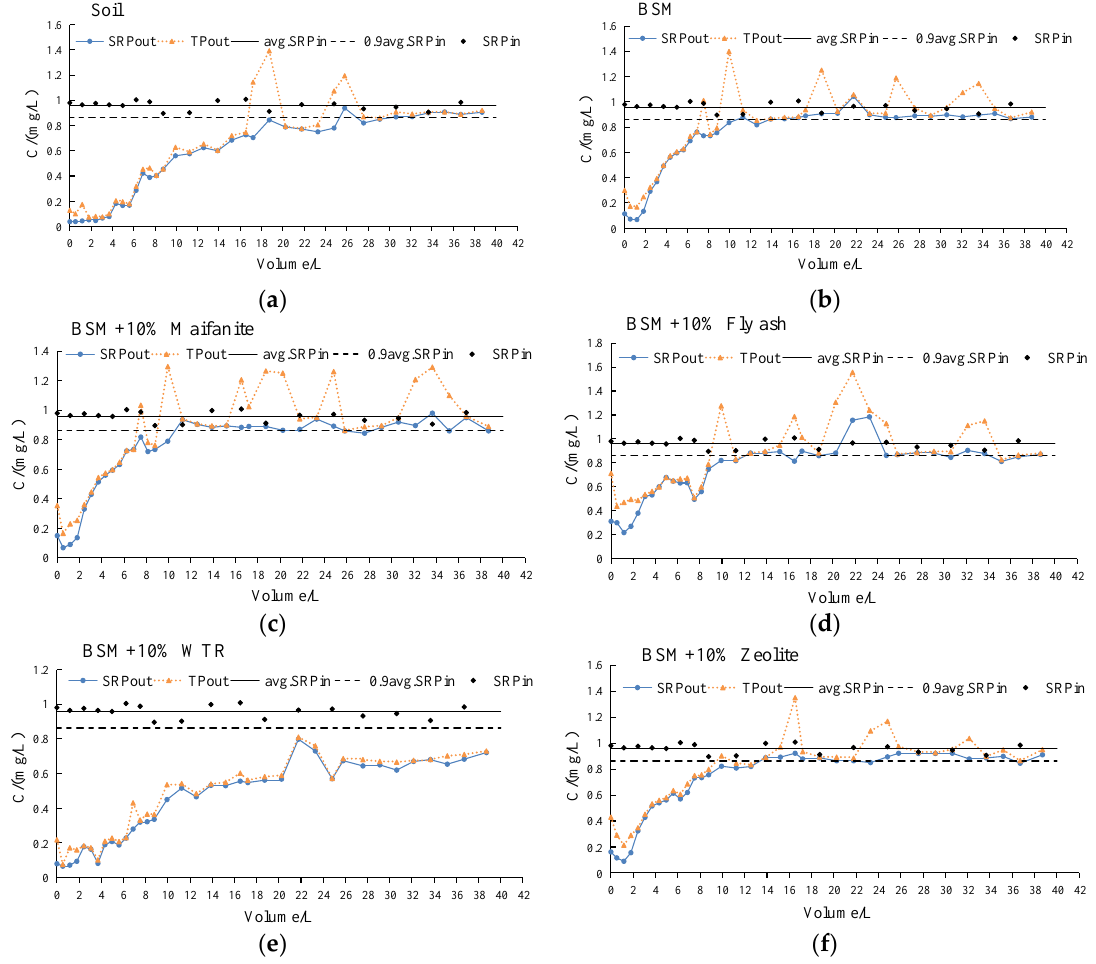
Figure 4. Dynamic adsorption curves of ( a ) soil, ( b ) BSM, ( c ) BSM+10% maifanite, ( d ) BSM+10% fly ash, ( e ) BSM+10%WTR and ( f ) BSM+10%zeolite for phosphorus.